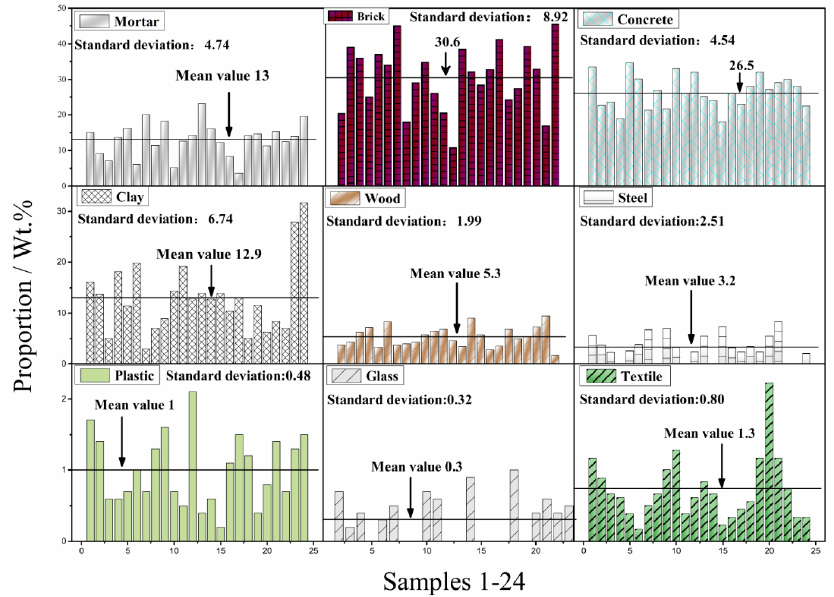
Figure 6. Constituents of CDW along the highway test section.